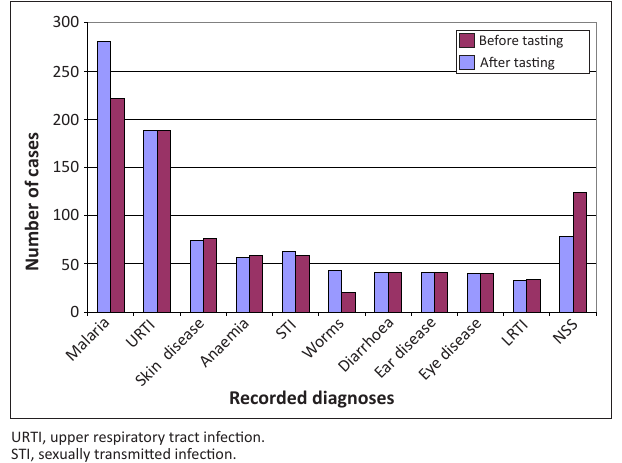
URTI, upper respiratory tract infection. STI, sexually transmitted infection. LRTI, lower respiratory tract infection. NSS, non-specific symptoms. FIGURE 1: Ten most common diagnoses in all health